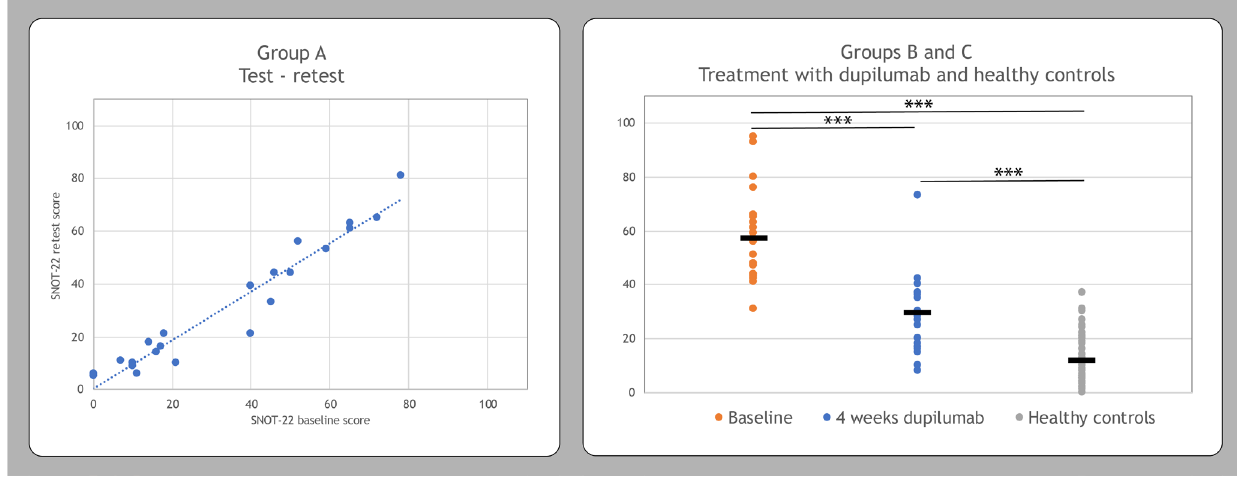
Figure 1. Left panel: outcomes for group A (test-retest): the x-axis shows the SNOT-22 scores at the baseline test; the y-axis shows those after 2-4 weeks. Dots indicate single patient outcomes. There is an excellent correlation between the two (dotted line). Right panel: SNOT-22 scores for group B before (orange dots) and after (blue dots) 4 weeks of dupilumab, and for group C (healthy controls; grey dots). Horizontal bars indicate the group mean SNOT-22 score. ***